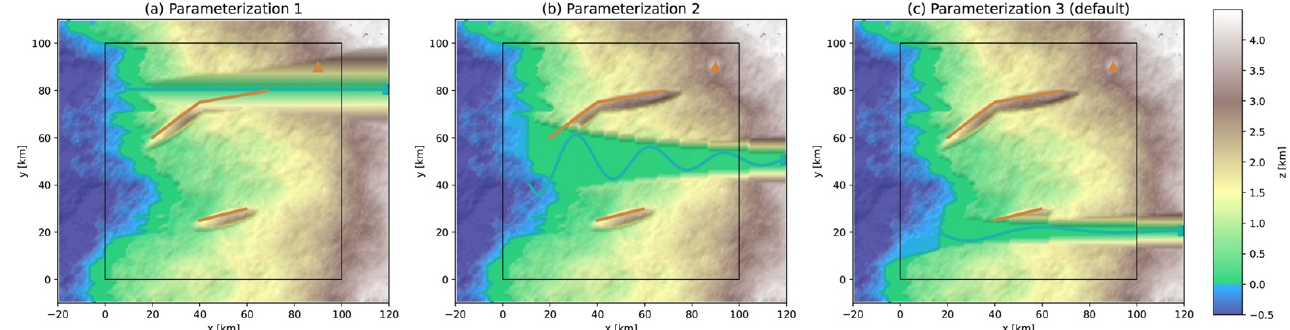
Figure 5. Generation of the river valley composed of a damped sine river and of a flat valley within the exponential contour of Equation (1). ( a ) Parameterization 1: V-shaped valley defined by A river = 0 km and tan φ valley = 1/4 for a river source located at y RF = 80; ( b ) Parameterization 2: Flat valley defined by A river = 20 km, ϕ river = 0.02, ω river = 0.2, and tan φ valley = 1/2 for y RF = 50; ( c ) Parameterization 3 ( digital template ’s default parameterization): Flat valley defined by A river = 10 km, ϕ river = 0.03, ω river = 0.1, and tan φ valley = 1/2 for y RF = 20. The parameter values were altered to illustrate the role of Equation (1) on topography intrusion, and do not necessarily represent realistic estimates of real